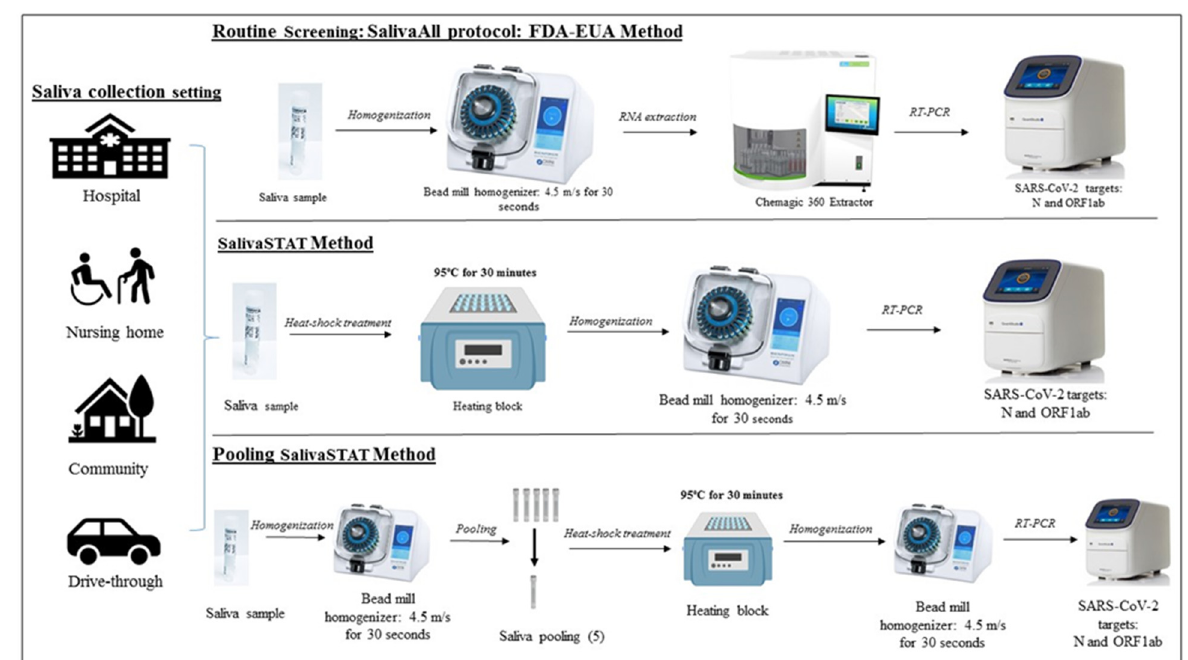
Figure 1. Schematic overview of sample processing and SARAS-CoV-2 assay workflow depicting main steps: Saliva samples collected in healthcare and community setting were tested and validated as follows: Upper panel: Saliva samples processed with SalivaAll protocol for nucleic acid extraction using a semi-automated instrument, followed by RT-PCR for N, ORF1ab gene targets and IC used as extraction and RT-PCR internal control; Middle panel: Saliva samples processed with SalivaSTAT method that included treatment of samples at 95 °C for 30 min and homogenization using a bead mill homogenizer followed by direct RT-PCR; Lower panel: Saliva samples homogenized using a bead mill before pooling samples with a five-sample pooling strategy followed by SalivaSTAT method for SARS-CoV-2 testing.